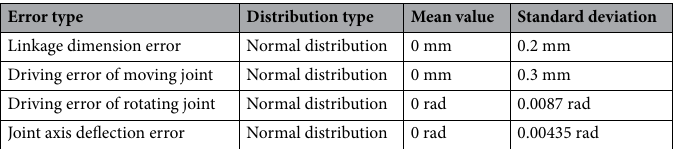
Table 1. The distribution of each